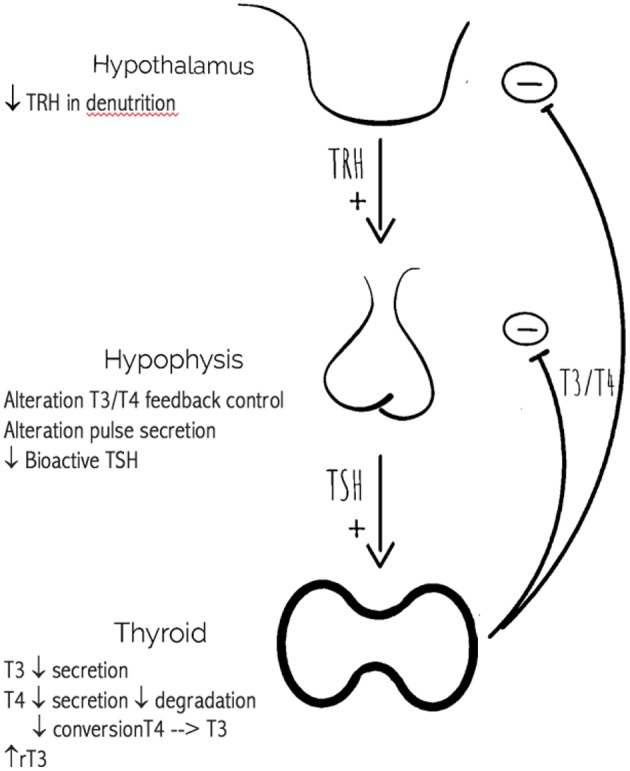
Age related changes in the hypothalamic-pituitary-thyroid axis.